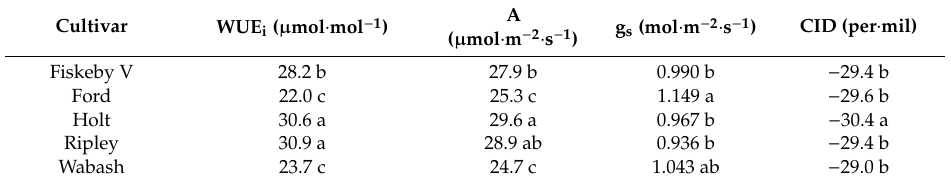
Table 3. Mean values of A, g s , WUE i , and carbon isotope delta (CID) values of five soybean cultivars measured on five dates in 2017. Values within columns followed by di ff erent letters were significantly di ff erent at P = 0.05, using a protected Least Significant Di ff erence (LSD) test.